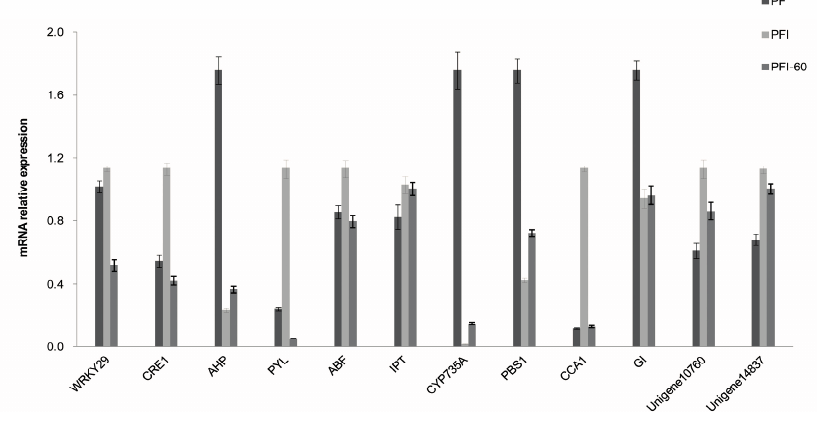
Figure 7. qRT-PCR analysis of candidate P. fortunei PaWB resistant genes. (The following genes were validated: WRKY transcription factor 29 ( WRKY29 ), WRKY protein; CRE1 , histidine kinase; AHP , histidine-containing phosphor transfer protein; PYL , abscisic acid receptor; ABF , ABA responsive element binding factor; IPT , adenylate isopentenyl transferase; CYP735A , cytokinin trans-hydroxylase; PBS1 , serine/threonine-protein kinase; CCA1 , circadian clock associated 1; GI , GIGANTEA; Unigene10760 , plasma intrinsic protein 2; Unigene14837 , plasma membrane H + -ATPase LilHA2. 18S rRNA was used as the internal reference gene. Standard error of the mean for three technical replicates is represented by the error bars. PF represents the healthy wild-type sample of P. fortunei. PFI represents the sample of phytoplasma infected PF. PTFI-60 represents the sample of 60 mg·L − 1 MMS treated